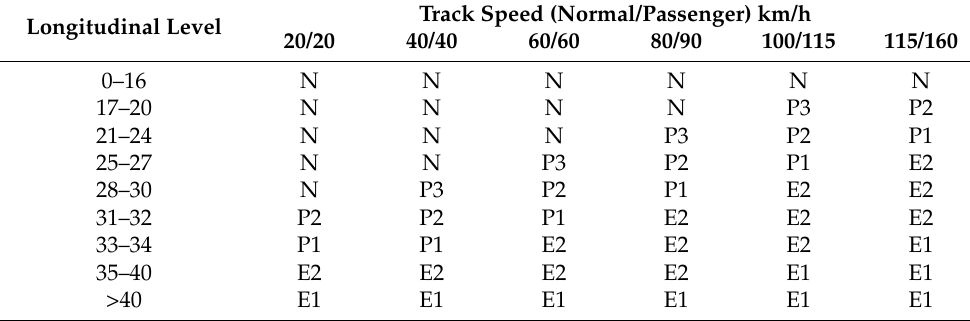
Table 1. Example of responses based on track geometry by TMC 203 [10].